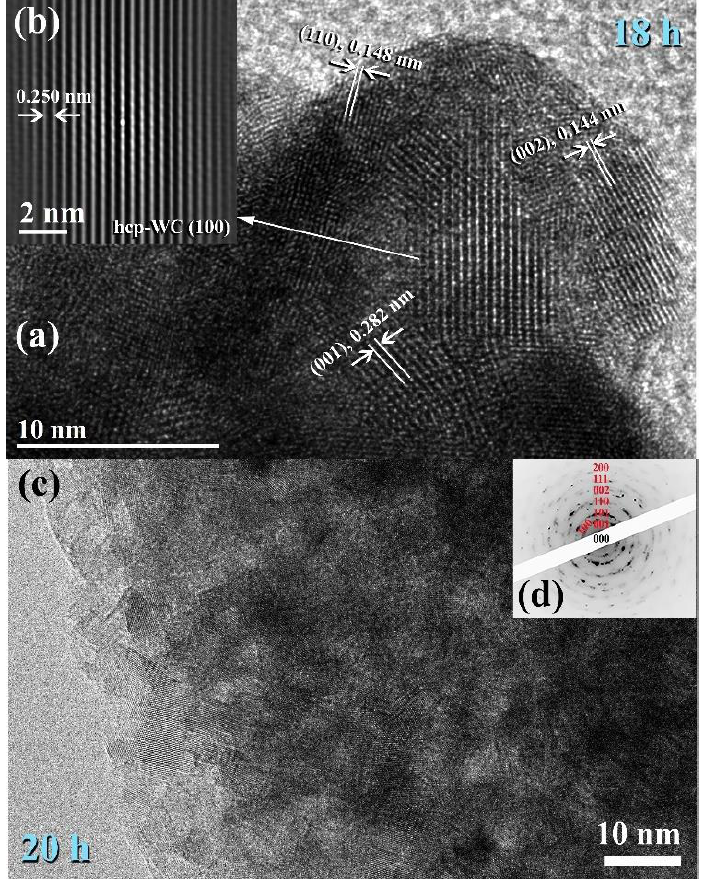
Figure 14. Images of FE-HRTEM for ball milled WC powders and their related selected area diffrac- tion patterns (SADPs) are shown in ( a , b ) and ( c , d ), respectively.